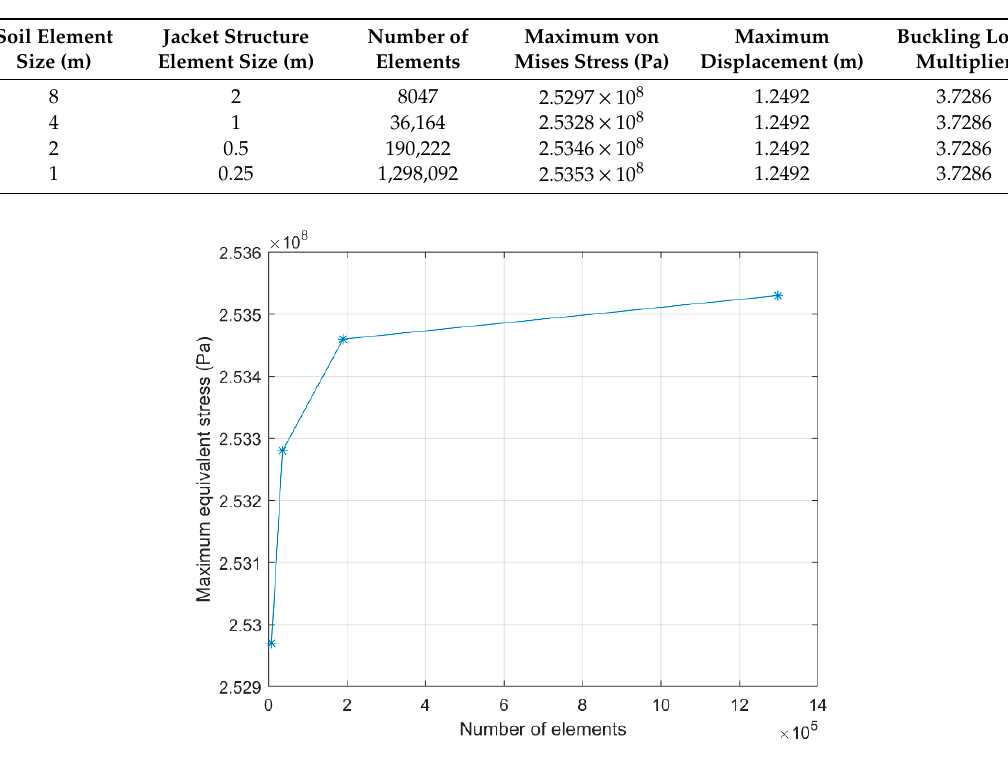
Figure 4. Three-dimensional (3D) display of meshing performed on the structural model. 5.1.3. Material The jacket structure is made of S355 structural steel with a density of 8500 kg/m 3 (increased by 8% to cover for secondary steel appurtenances, coatings, and welds that are not covered for in the thickness data of the support structure), Young modulus of 210 GPa, a Poisson’s ratio of 0.3, and a